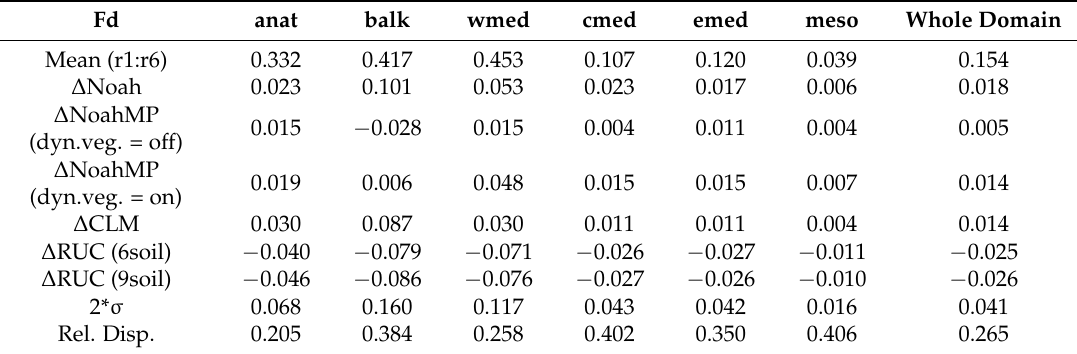
Figure 5. Fuel dryness index (Fd) for the summer period (JJA) averaged for 2000–2010 by Noah (on the right-hand side) and the differences in Fd by NoahMP dyn. Veg. = OFF & ON, CLM and RUC 6 and 9 soil layers from Noah. Table 3. Mean values of Fd derived from the six experiments, the difference ( ∆ ) of each run from the overall mean value, two times standard deviation and the “relative dispersion” for the six sub-domains (Anatolia, Balkans, western, central & eastern Mediterranean and Mesopotamia) and the reduced MENA